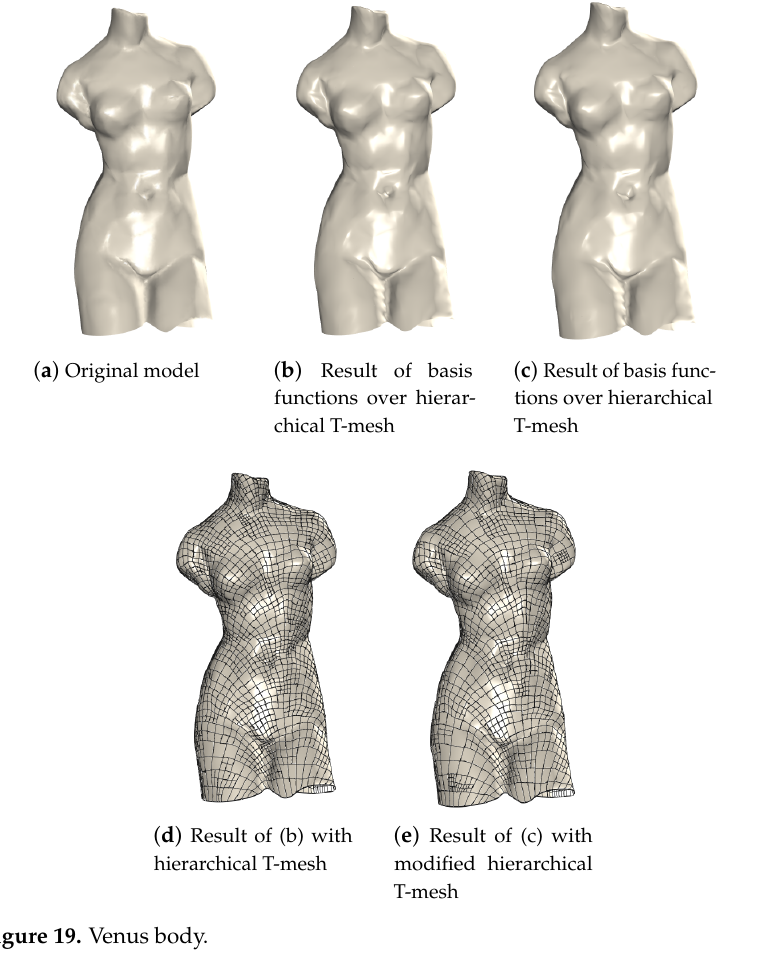
Figure 19. Venus body. Table 2. Experiment